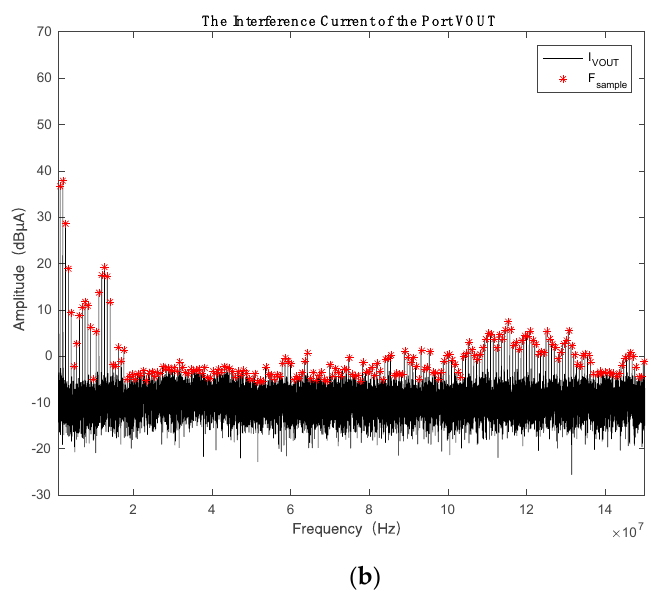
Figure 3. The measured results U measured ( a ) the measured conducted emission U VIN at the port VIN; ( b ) the measured conducted emission U VOUT at the port VOUT.